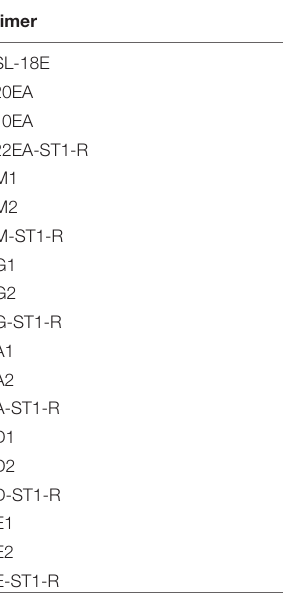
TaBle 1 | Primers used in this